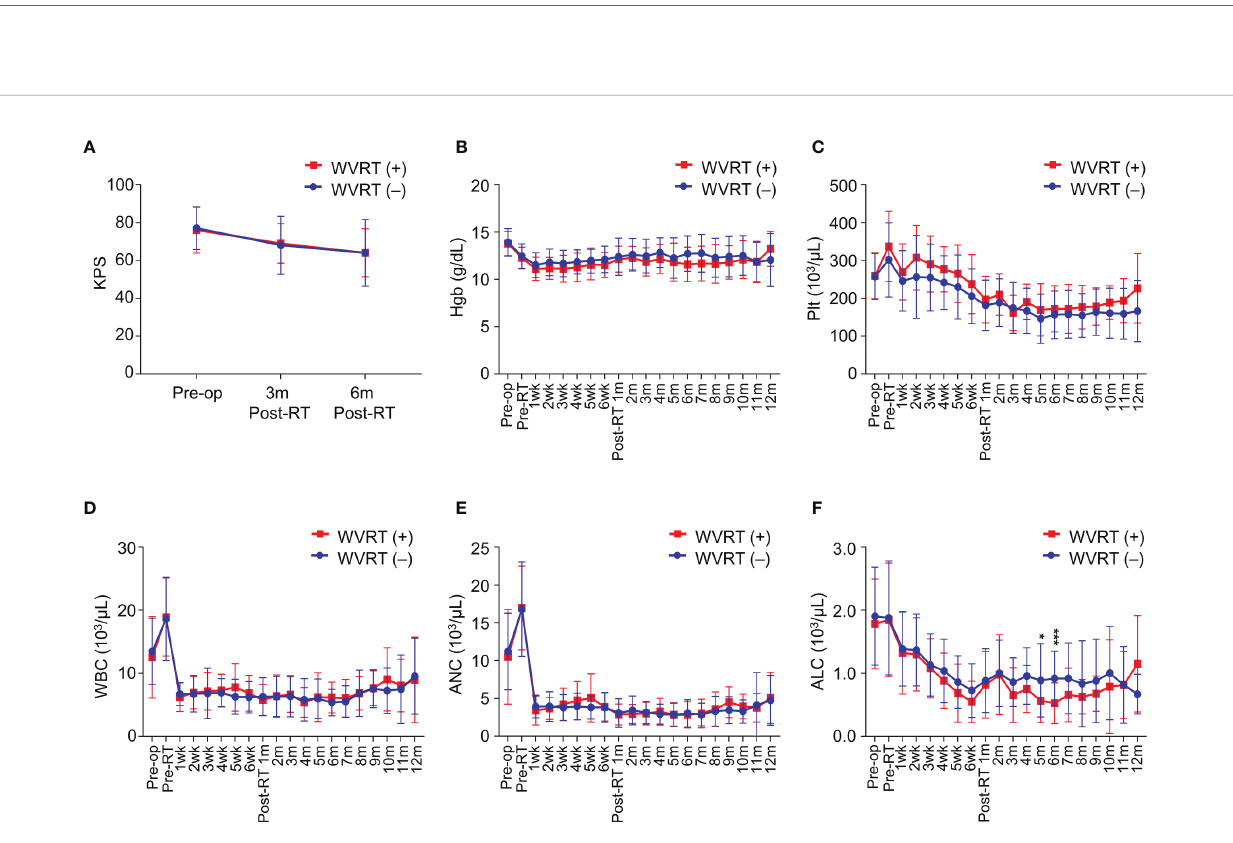
FIGURE 4 | A representative case of intraventricular failure. (A) A typical case of WVRT after ventricle opening where the whole ventricle, including the lateral, third, and fourth ventricles are included. (B) A patient who did not receive WVRT but had the adjacent lateral ventricles included in the fi eld. This patient experienced recurrence in the fourth ventricle 7 months post-surgery without local recurrence. WVRT, whole-ventricular radiotherapy.